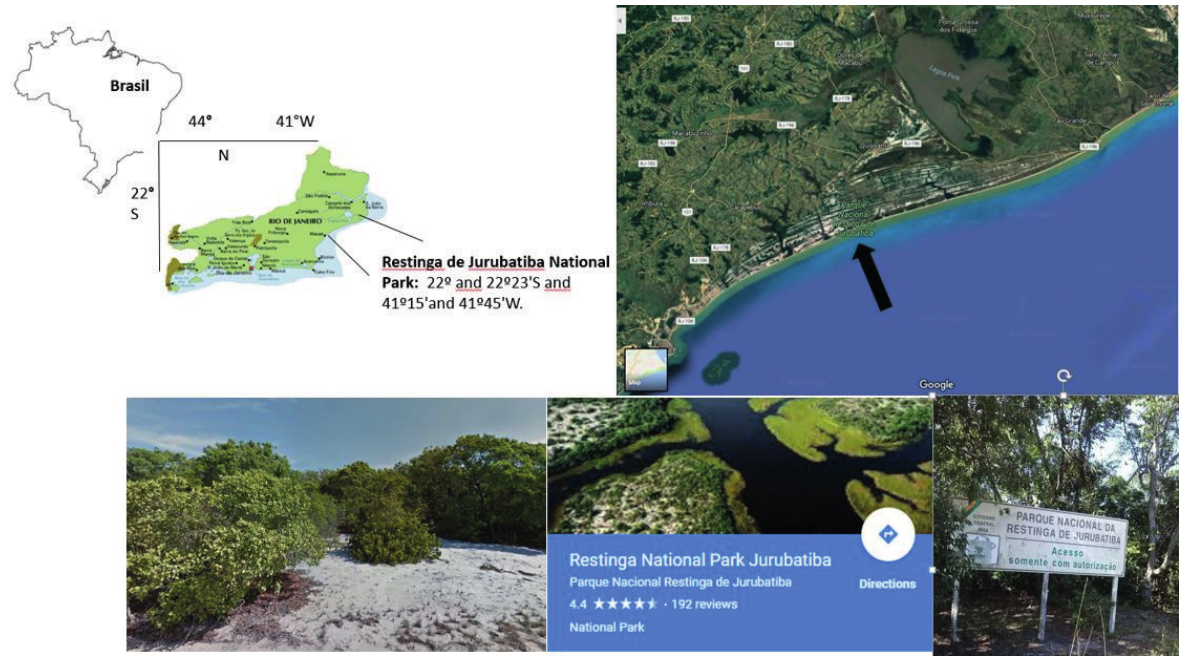
Figure 1 - Map showing the coordinates of Restinga de Jurubatiba National